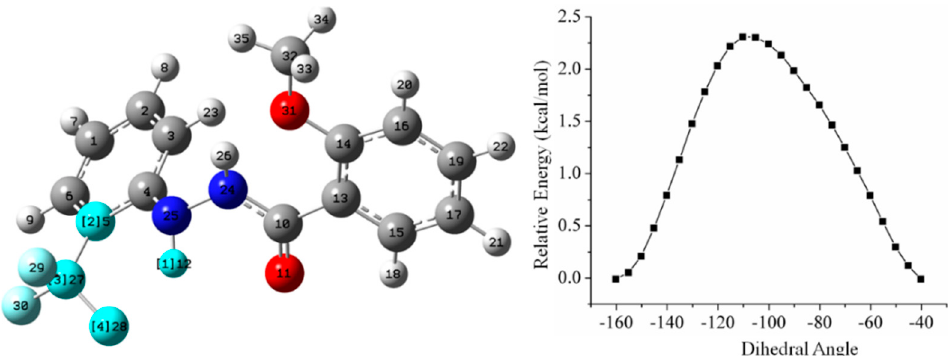
Figure 23. Relaxed potential energy surface Scan for the internal rotation of the CF 3 group. The scan was performed in 28 steps with increments of 5° in the dihedral angle.